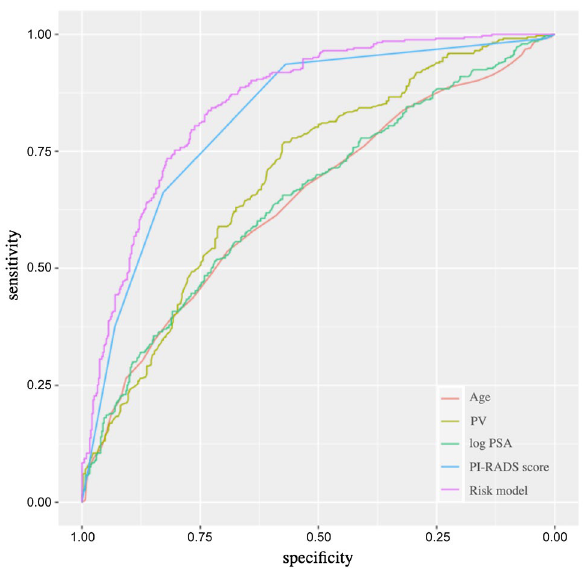
Figure 2. ROC curve analysis for the performance of age (red line), PV (yellow line), PSA (green line), bpMRI PI-RADS (blue line) and risk model (purple line) to predict